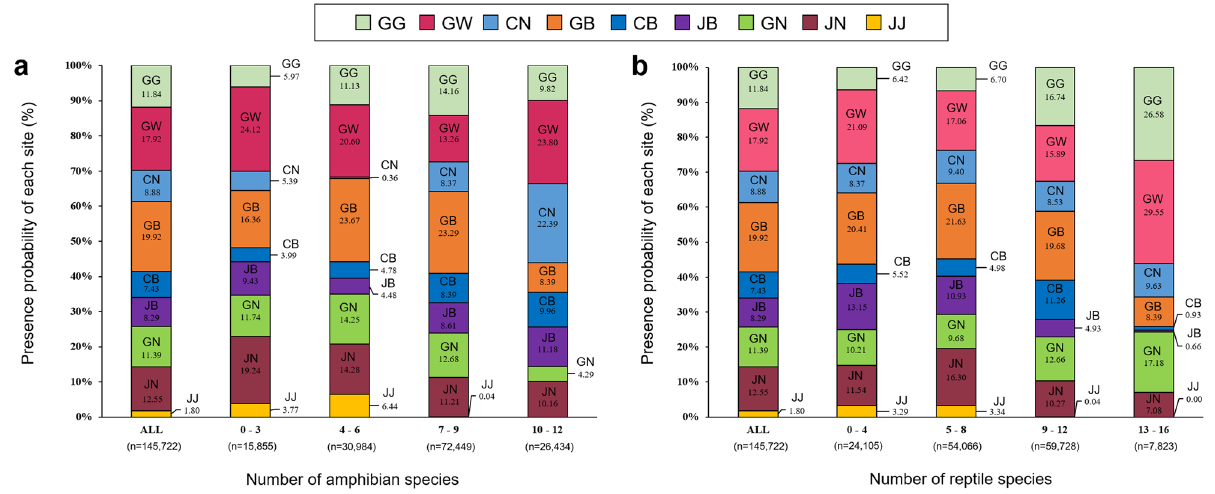
Figure 3. Percentage distribution of each province according to the number of cells in which the presence of ( a ) the 19 amphibian species and ( b ) the 20 reptile species were predicted. Province abbreviations: GG Gyeonggi,